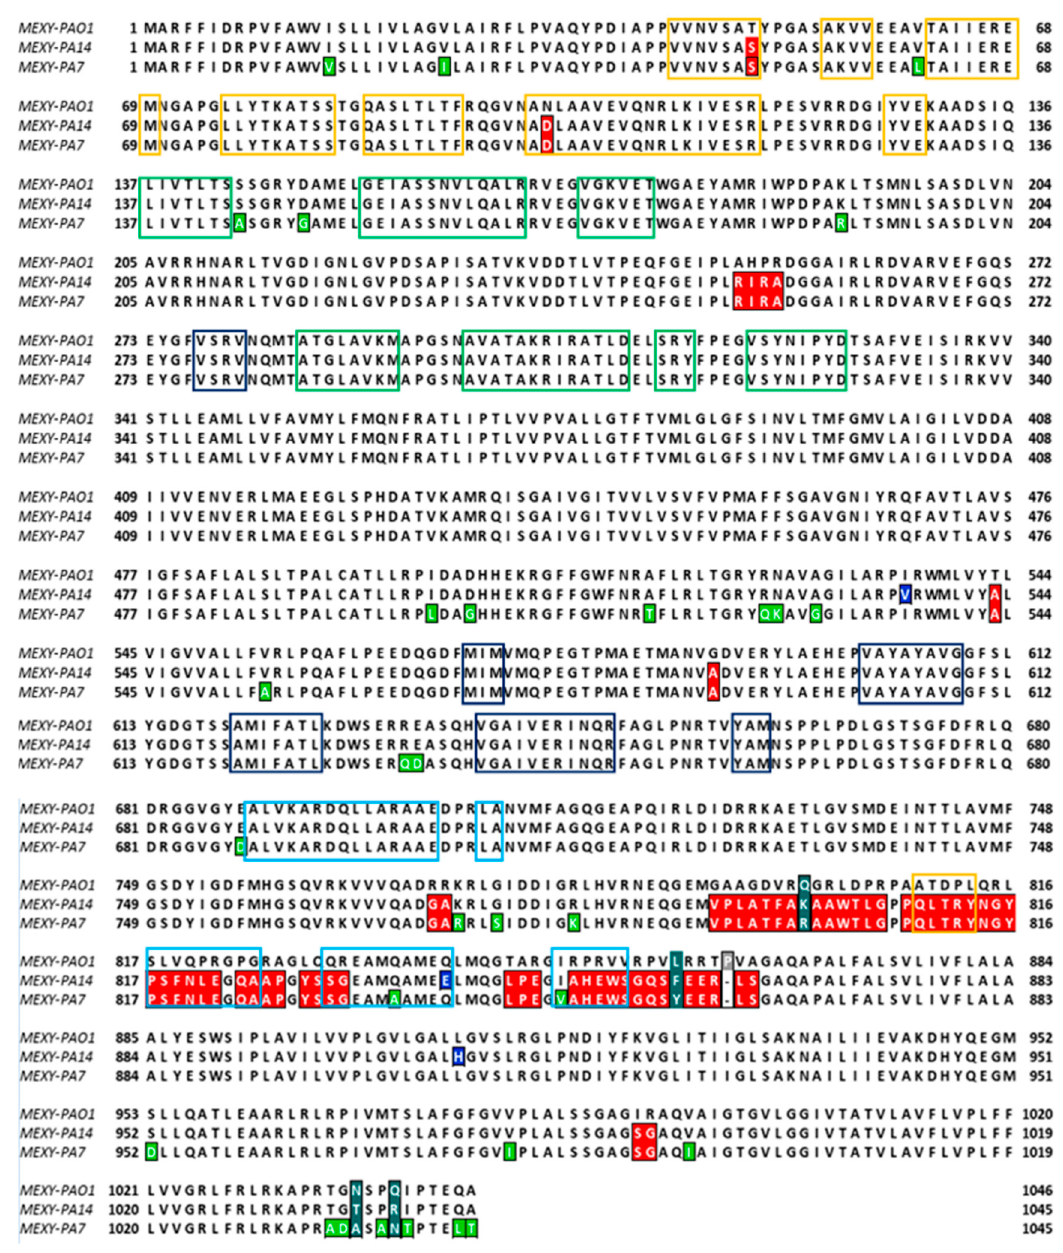
Figure 2. Multi-alignment of the MexY sequences of P. aeruginosa PAO1, PA7, and PA14 (MAFFT algorithm). The MexY aminoacidic sequence of P. aeruginosa PAO1 was considered the reference sequence. The conserved residues in both PA7 and PA14 are colored in red, while those peculiar to PA7 or PA14 are in green and blue, respectively. Different color boxes indicate that the aminoacidic pattern belonged to subdomain: PC1 (blue), PC2 (light-green), PN1 (yellow), or PN2 (green).